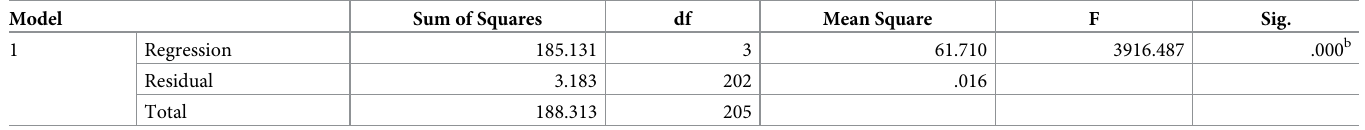
Table 5. ANOVA of service innovation practices and customer loyalty. Model Sum of